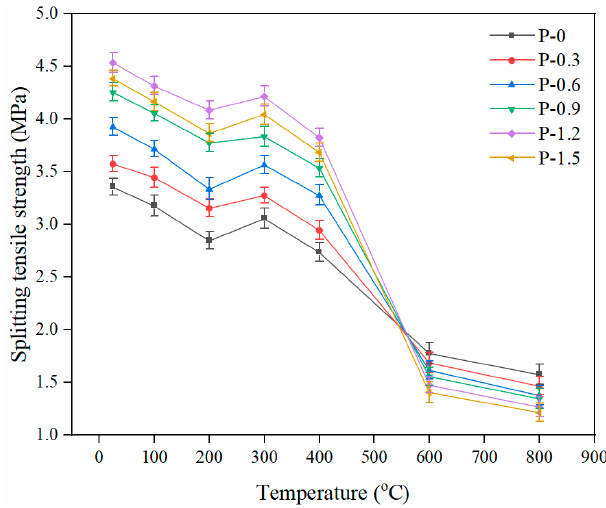
Figure 7. Splitting tensile strength of PVA-FRCC specimens with different fiber contents.